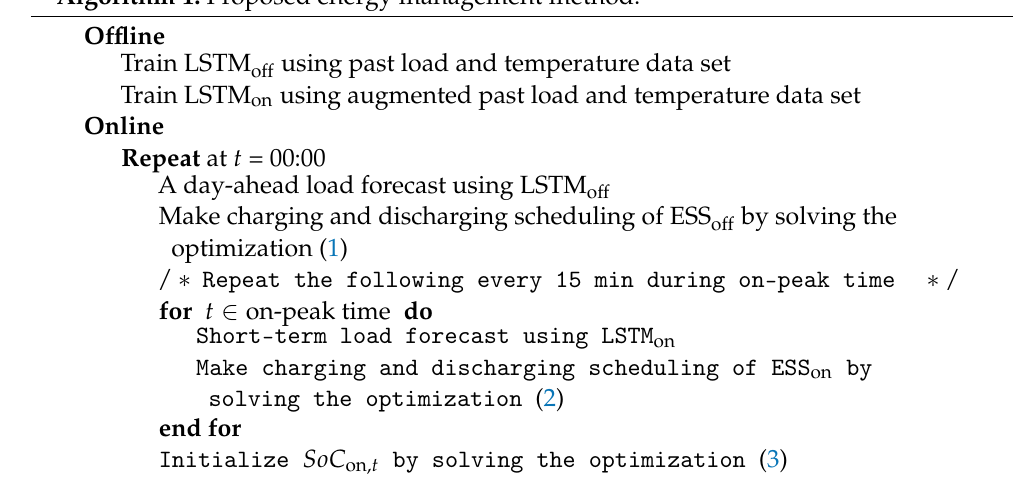
Algorithm 1: Proposed energy management